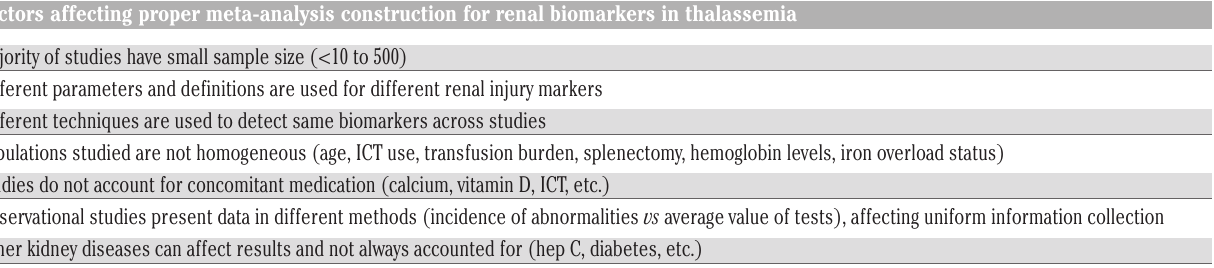
Table 3. Guidance for management of renal issues with iron chelation